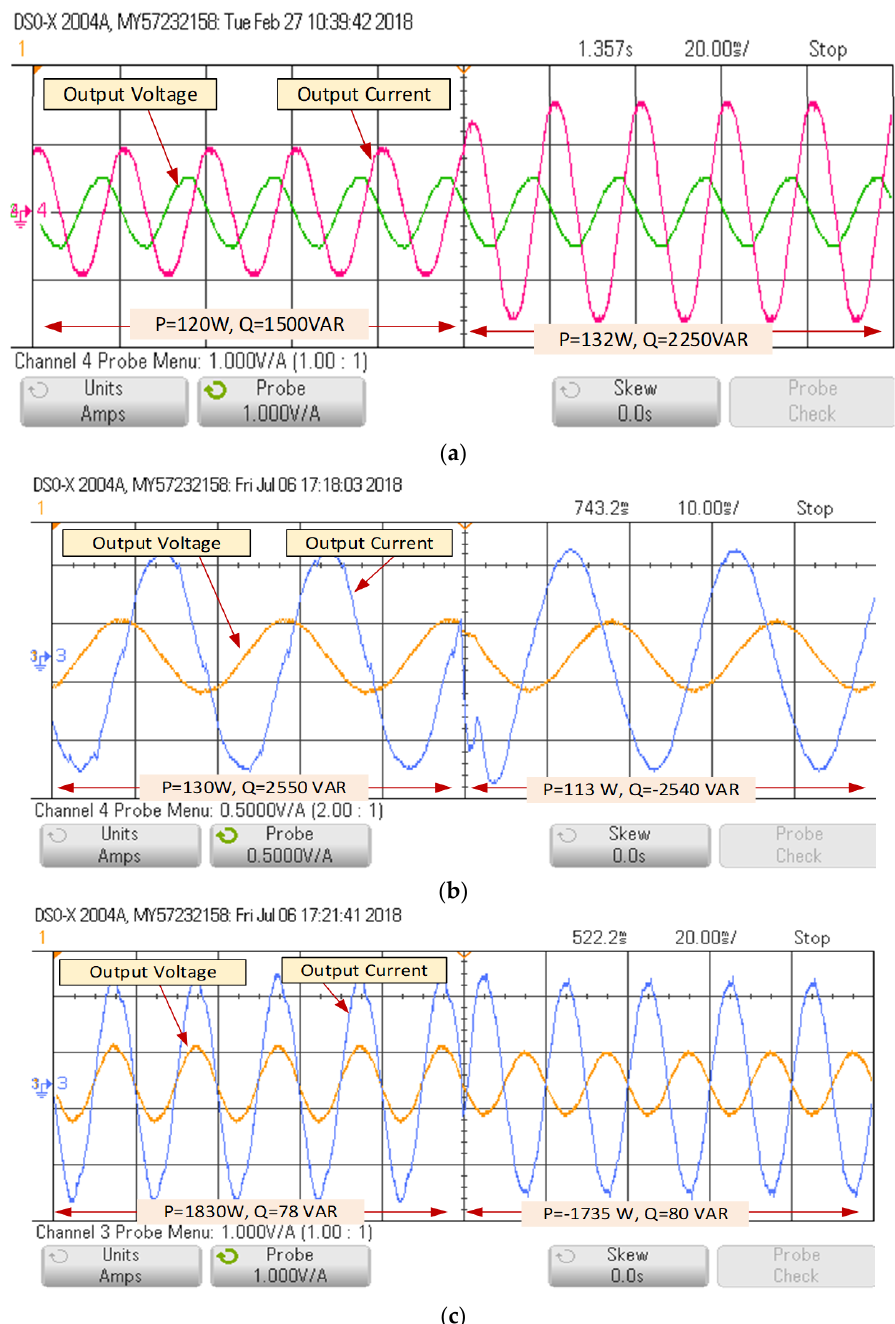
Figure 14. The experimental test results for power flow control, ( a ) the reactive power has been changed from 1.5 kVAR to 2.25 kVAR and is of inductive type, ( b ) the reactive power injected into the utility grid by the inverter has been changed from inductive (2.55 kVAR) to capacitive (2.54 kVAR), and ( c ) the inverter is supplying 1.83 kW to the load and utility grid, and then the active power is changed to 1.73 kW in the reverse direction to charge the